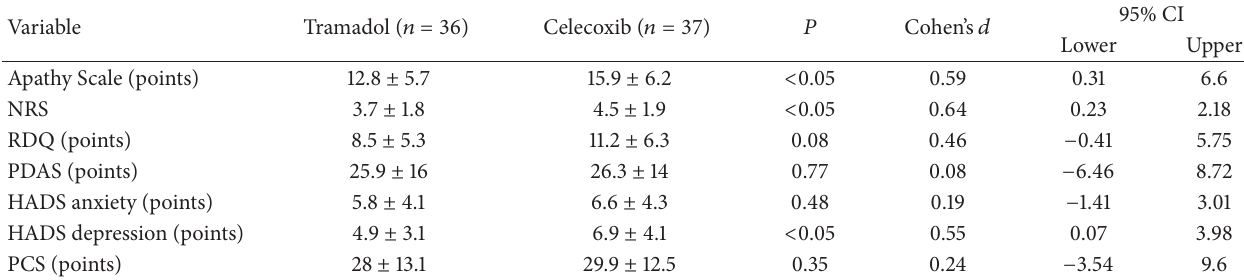
Table 2: Apathy, NRS, RDQ, PDAS, HADS, and PCS scores after four-week treatment in the tramadol and celecoxib